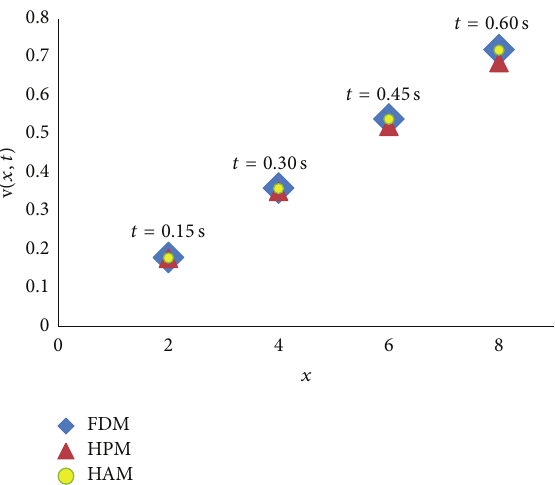
Figure 1: The comparison of HPM, HAM, and FDM for the solution V (𝑥,𝑡) for different values of 0 ≤ 𝑥 ≥ 4 and 0 ≤ 𝑡 ≥ 0.04 ; ℏ = 0.001 .